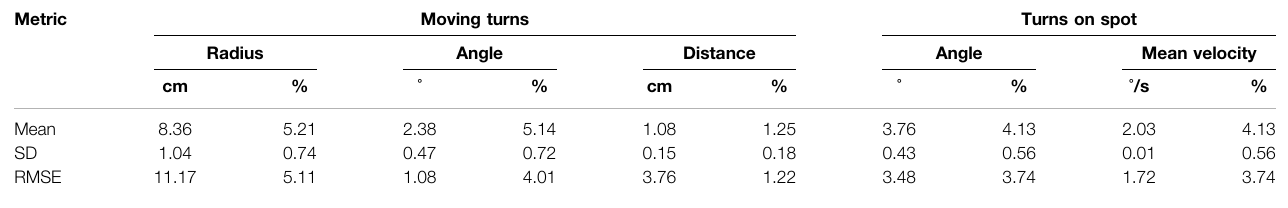
TABLE 2 | Values from error analysis in units and percentage.